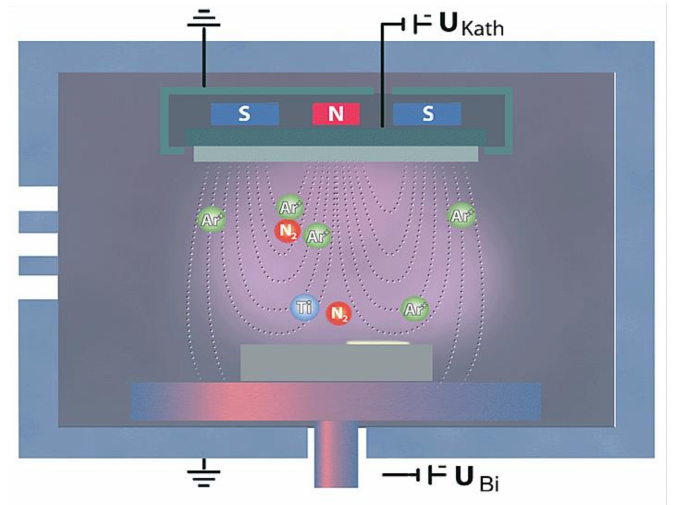
Figure 2. The principle of HIPIMs sputtering (source CemeCon)